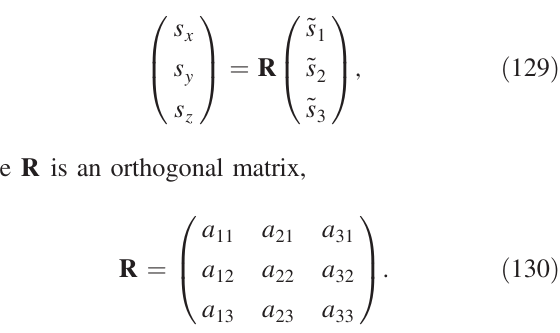
FIG. 3. (a) In the bend plane the spin vector s has precessed through angle ~ α away from its nominal direction along the proton ’ s velocity. (Remember that different particles have differ- ent bend planes.) (b) Projection of (a) onto the laboratory horizontal plane. The projected longitudinal axis is shown coinciding with the laboratory longitudinal axis, even if this is not exactly valid. x is the deviation of the (bold face) particle orbit from the (pale face) design orbit. If the bend plane coincides with the design bend plane (as is always approximately the case) and ˆ z are identical. θ is the reference particle deviation angle from longitudinal and ϑ is the tracked particle deviation angle from longitudinal. On the average θ and ϑ are the same, but betatron oscillations cause them to differ on a turn by turn basis, and also to make the instantaneous bend plane not quite